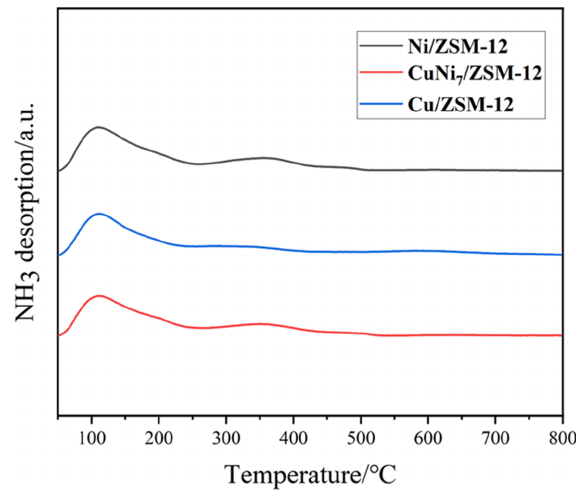
Figure 6. NH 3 -TPD results of Ni/ZSM-12, CuNi 7 /ZSM-12 and Cu/ZSM-12. Table 2. Relative acid amounts of different catalysts.